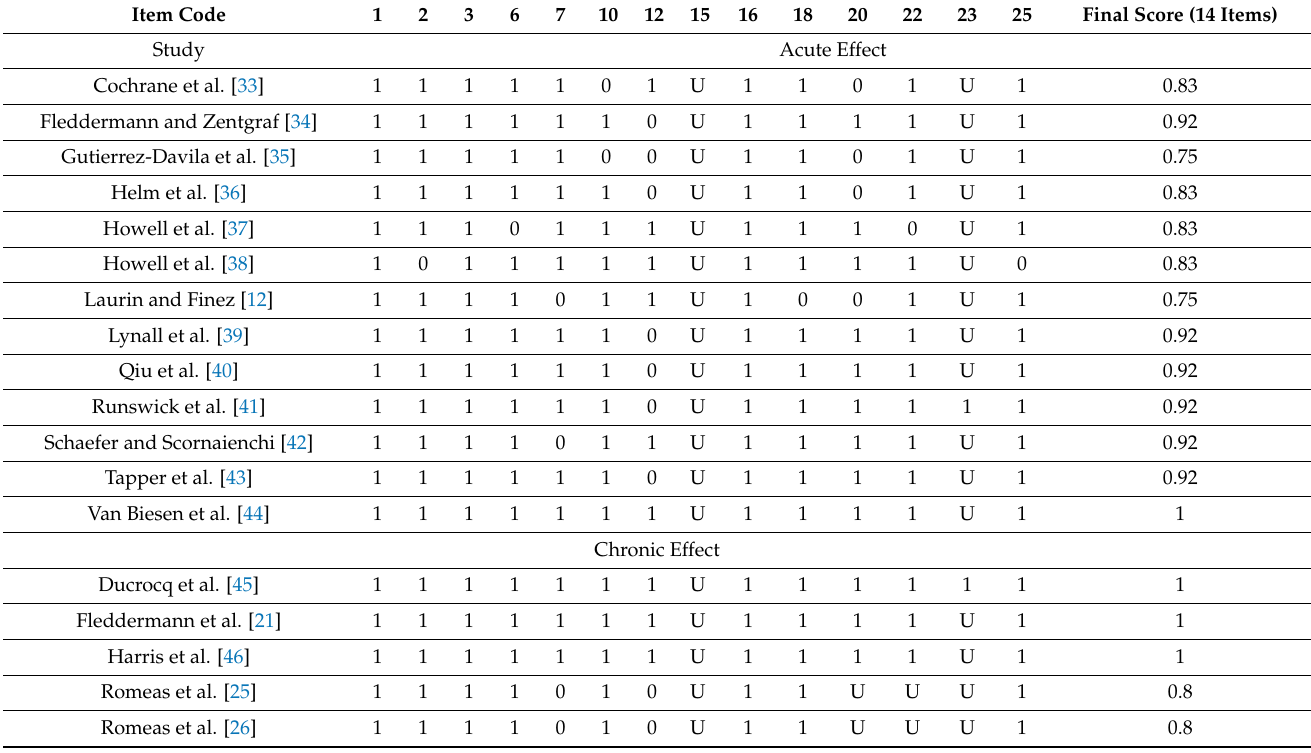
Table 1. The methodological quality of each study included in the review based on the Quality Index Scale and divided according to study design (acute and chronic